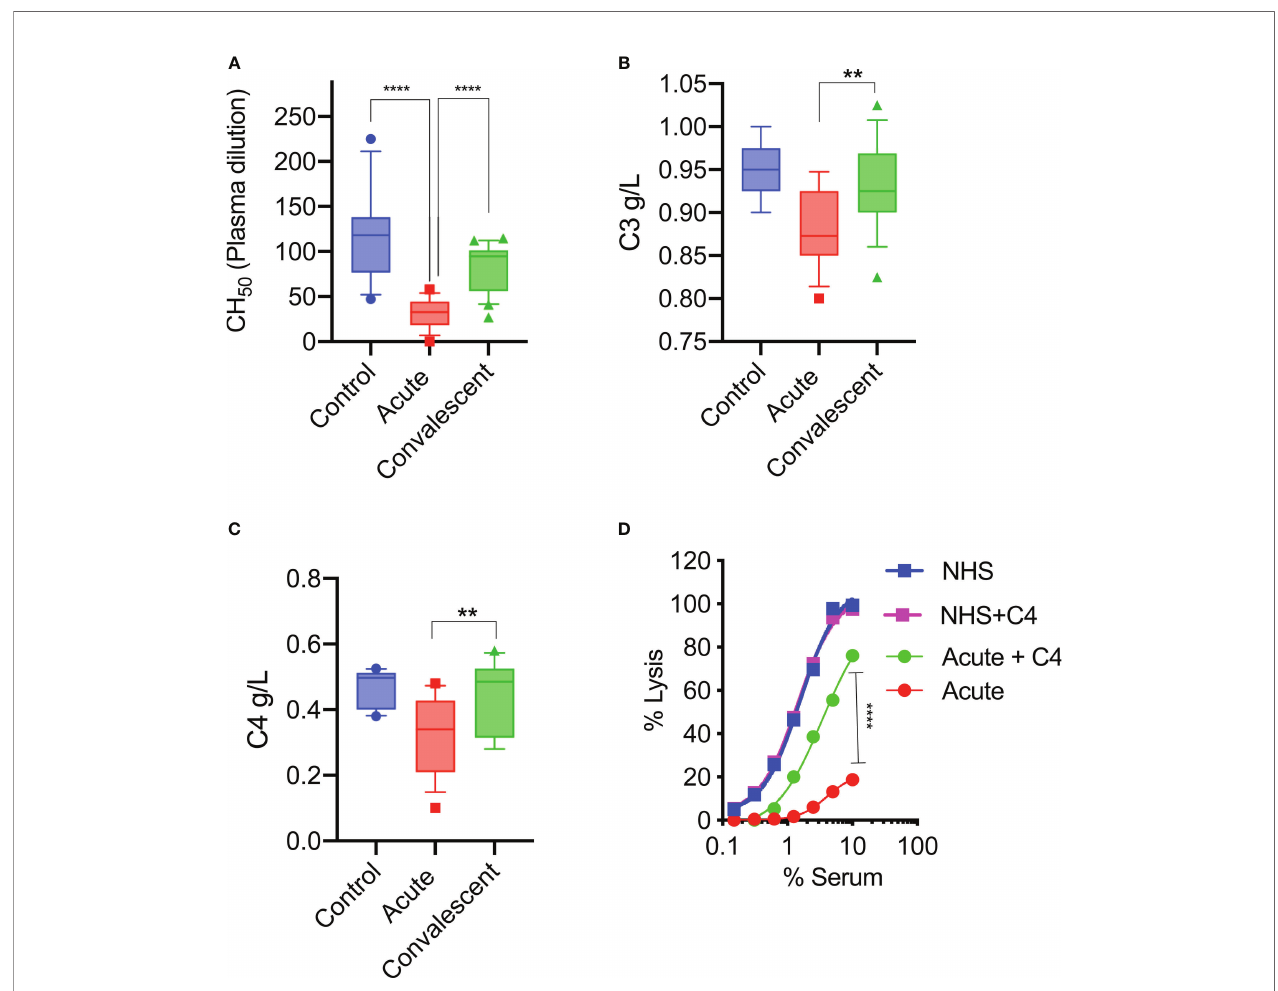
FIGURE 4 | At hospital admission, sera of severely ill COVID-19 patients lack complement functional activity. Sheep RBCs were coated with anti-sheep erythrocyte antibodies and incubated with different serum concentrations. The serum dilution required to lyse 50% of RBCs (CH 50 ) was calculated. The haemolytic activity of sera from acute COVID-19 patients (n= 25) is signi fi cantly impaired compared to sera from the same patients after recovery or to those of control NHS (n=14) (A) . Serum levels of complement C3 and C4 were also signi fi cantly lower in acute sera compared to convalescent sera and control sera (NHS) (B, C) . Results were analysed using 1-way ANOVA, with Dunnett ’ s correction for multiple comparisons. **** p < 0.0001, ** p < 0.01. Reconstitution of sera taken during the acute phase of severe COVID-19 with 10 m g/mL of puri fi ed C4 restored the de fi cient haemolytic activity (D) . Results were analysed using 2-way ANOVA with Sidak ’ s multiple comparison